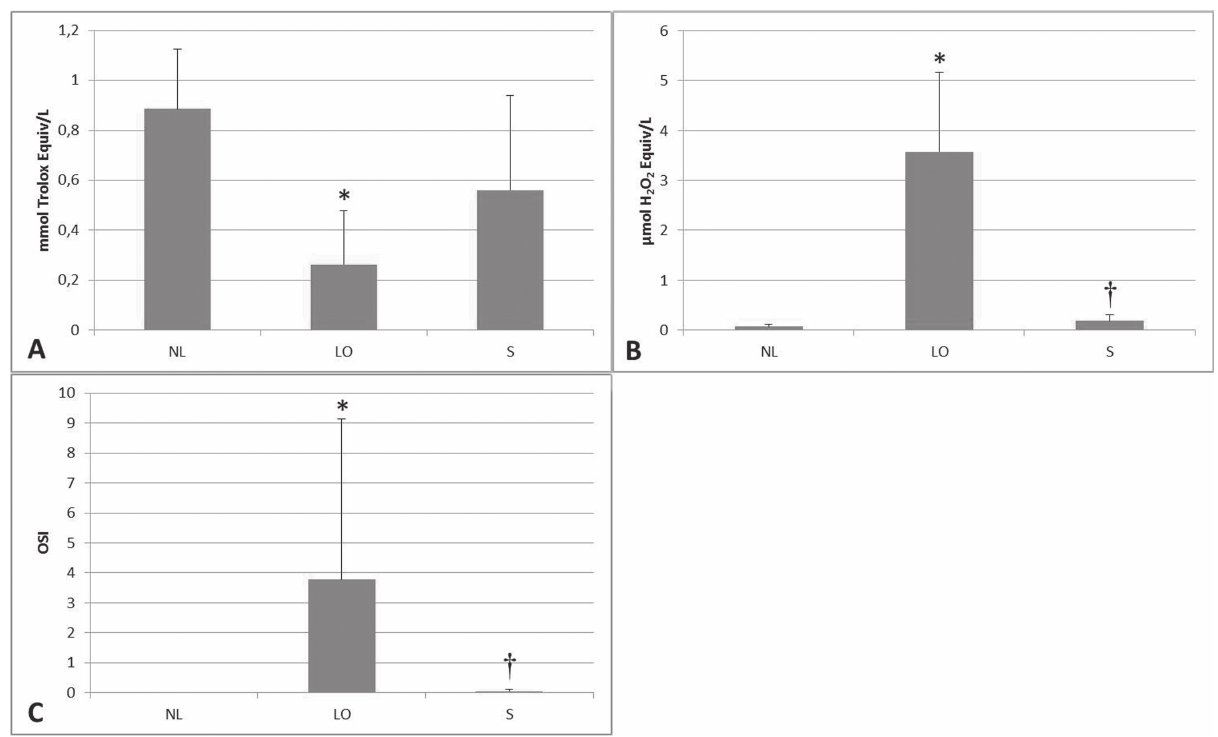
Figure 5- A- Mean and standard deviation of RANKL-positive cells in the groups; B- Mean and standard deviation of OPG-positive cells in the groups. *Significant difference compared to NL group. †Significant difference compared to LO; C- RANKL/OPG ratio in the